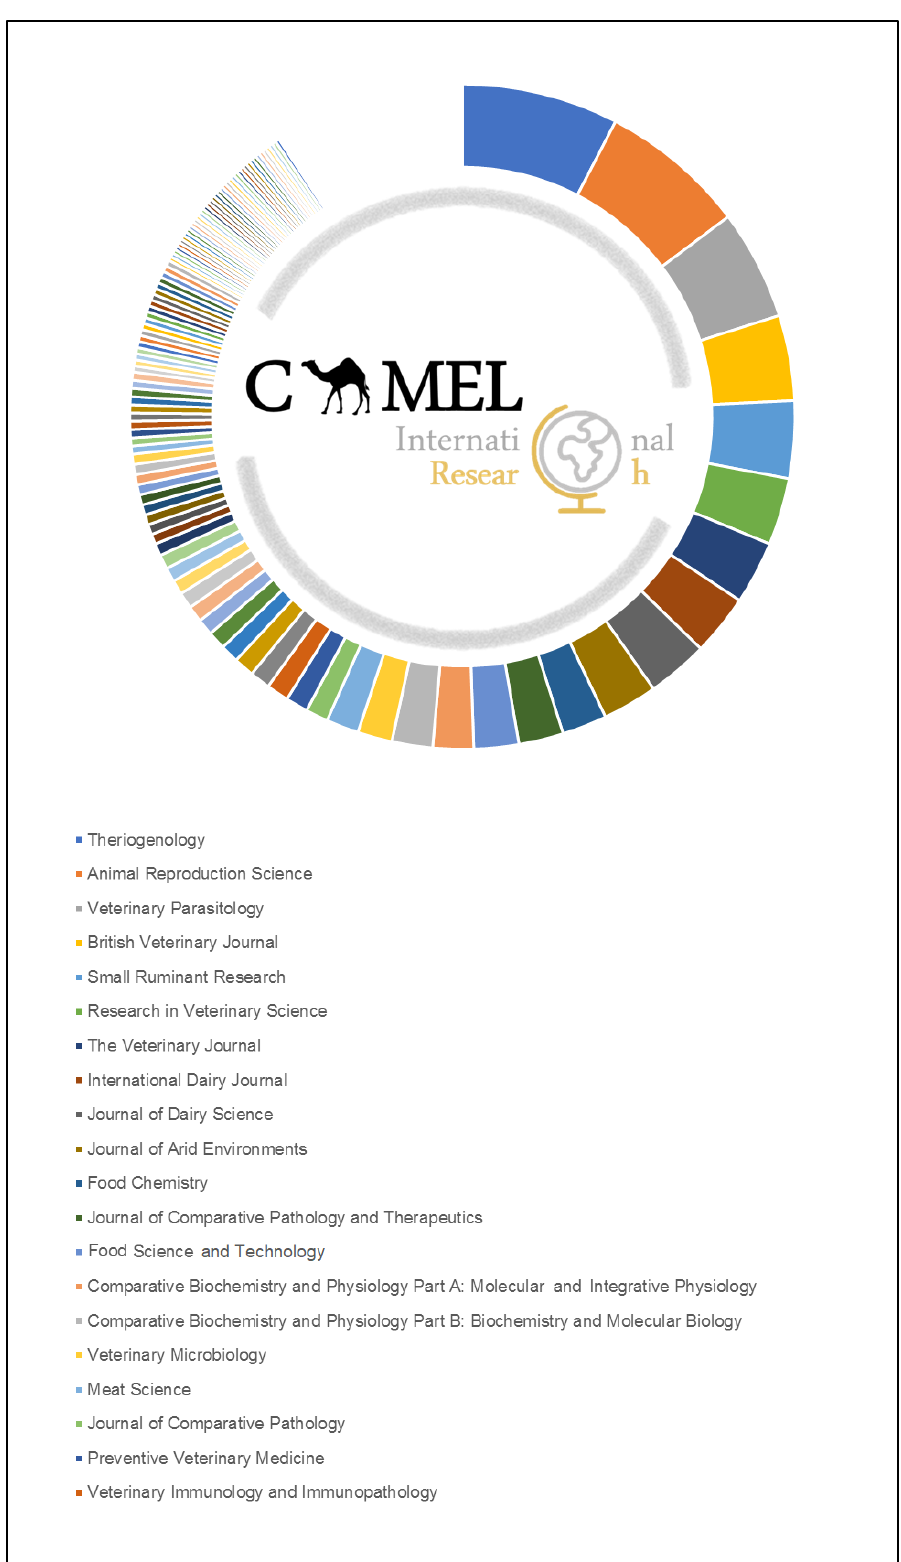
Figure 2. Number of historical publications on camels across journals.